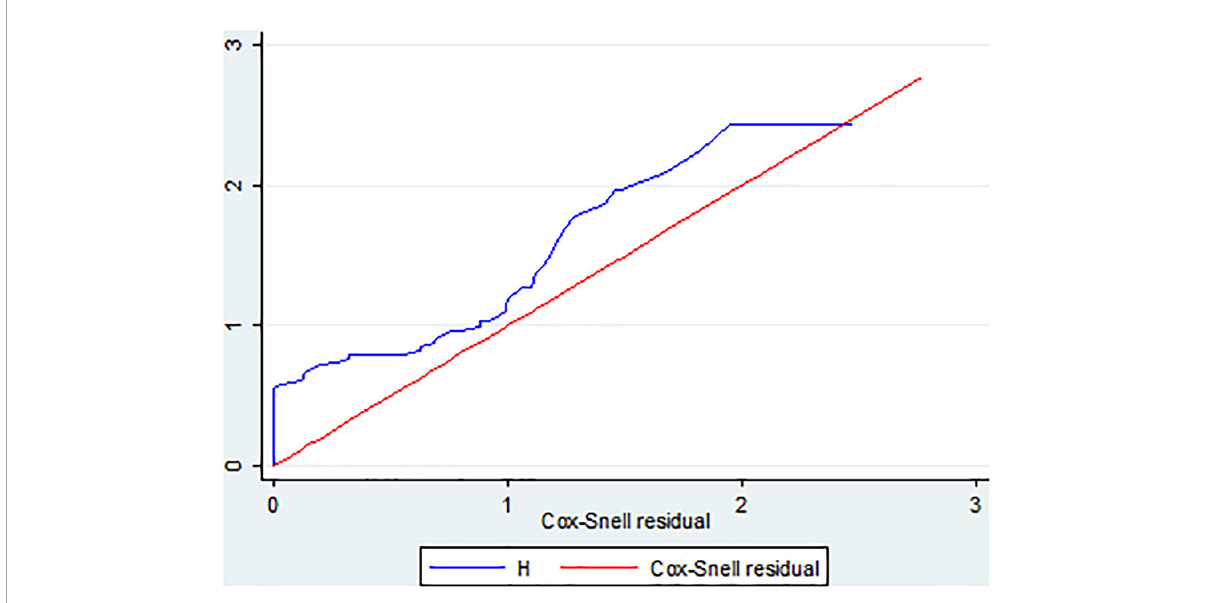
FIGURE4 The Cox Snell residual overall model fitness test of LBW neonates admitted to the NICU of FHCSH, Ethiopia from 1 January 2015 to 30 December